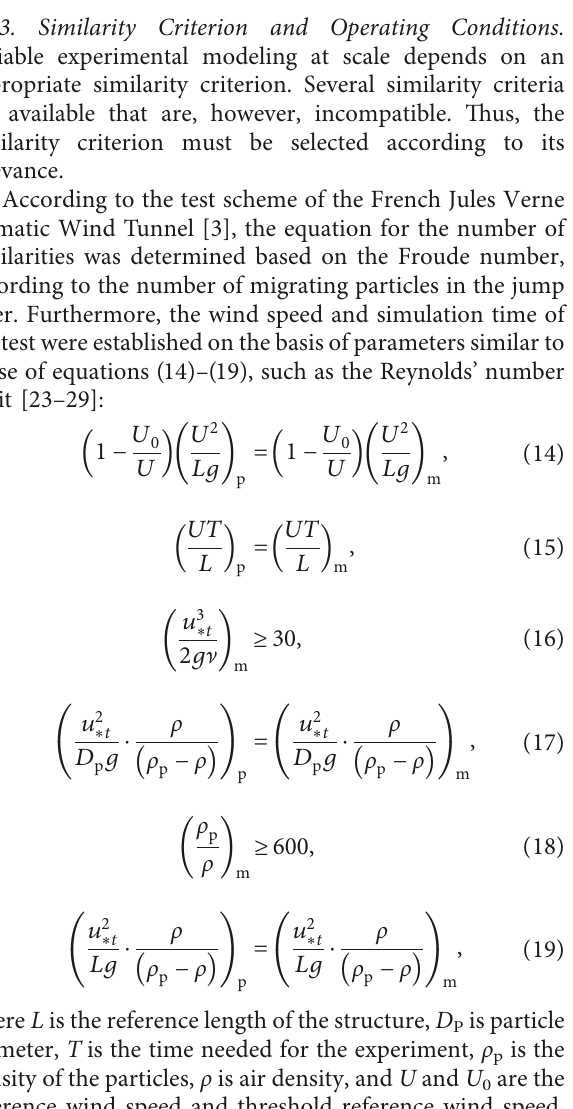
Figure 4: Snow-wind combined experimental